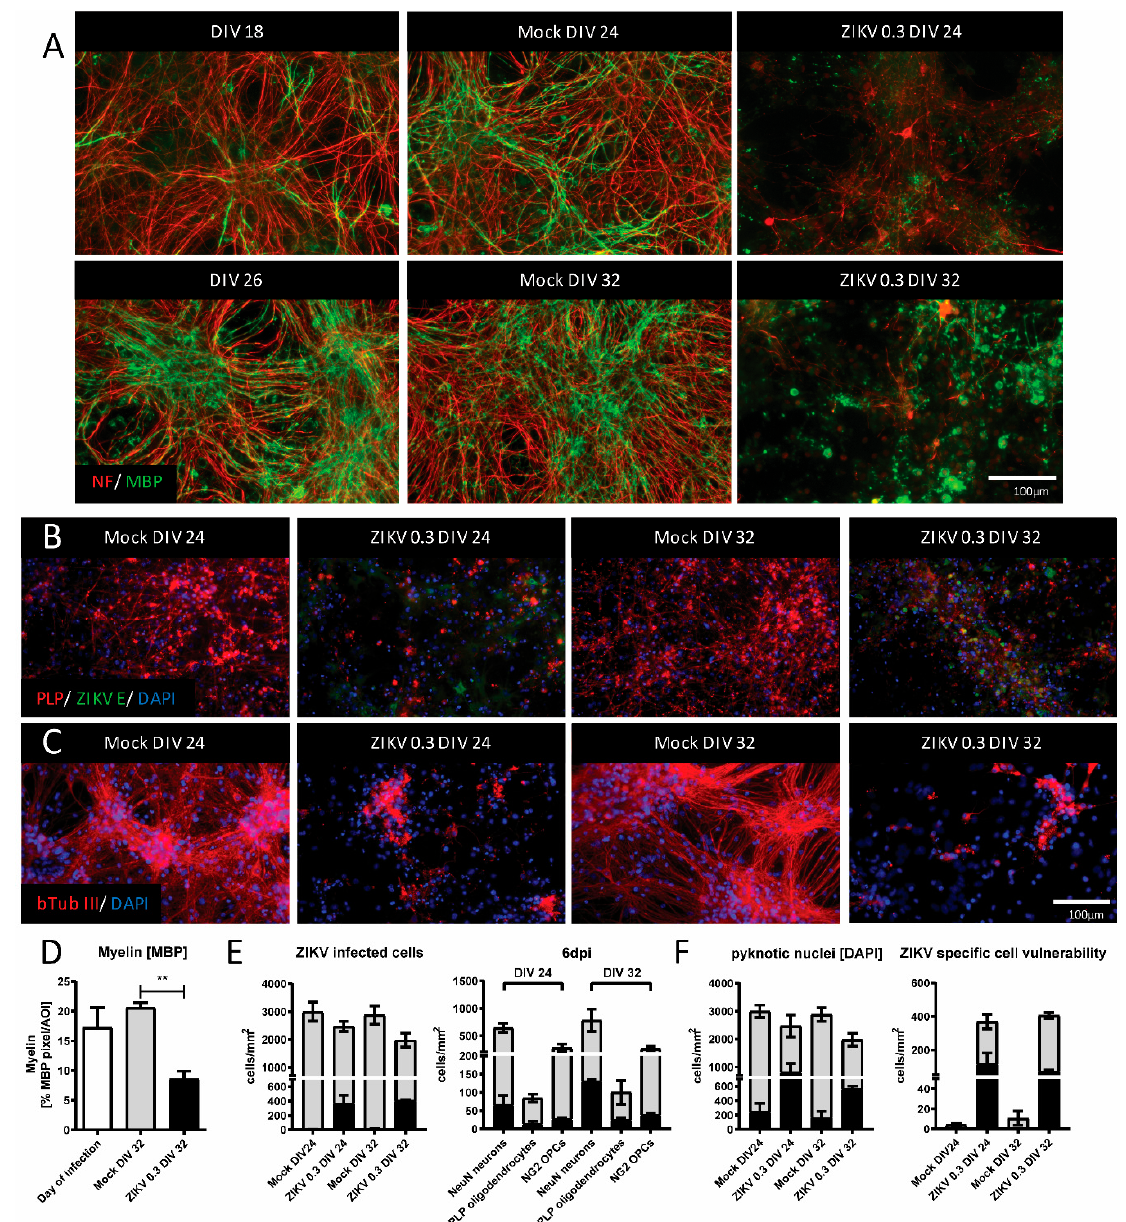
Figure 2. ZIKV infection causes damage to mature, myelinated CNS cultures. ( A ) Mouse CNS myelinating cultures were either mock- or ZIKV-infected (MOI 0.3) at DIV 18 (upper panel) or DIV 26 (lower panel) and analyzed by IF at 6 dpi. Mature myelin basic protein (MBP, green signal) and axon (NF, red signal) staining are shown, representative of four biological replicates ( n = 4). ( B,C ) IF analysis of myelin (PLP, red signal) and axons ( β -Tubulin III, red signal). ZIKV infection was assessed with an antibody recognising ZIKV E protein (green signal). A total of four biological replicates ( n = 4) were analyzed. ( D ) Quantification of myelin with Cell Profiler software. n = 4; Mean ± SEM; paired t test; ** p < 0.01. ( E ) CNS cells in mature and immature cultures were quantified ( n = 2; Mean ± SEM), to show susceptibility to ZIKV infection. Gray bars represent the overall cell number and black bars represent the number of infected cells. Left panel, overall numbers; right panel, cell types. ( F ) Cell death was quantified by assessing DAPI stained nuclei (left panel). Gray bars represent the overall density of nuclei, while black bars represent the proportion of pyknotic nuclei ( n = 2; Mean ± SEM). A high proportion of ZIKV-infected cells underwent cell death as assessed by DAPI-stained nuclei (right panel); gray bars represent the overall density of ZIKV-infected cells, black bars represent the proportion of ZIKV-infected cells with pyknotic nuclei ( n = 2; Mean ± SEM). ZIKV E staining showed very low background in mock-infected cultures, which are indicated here for